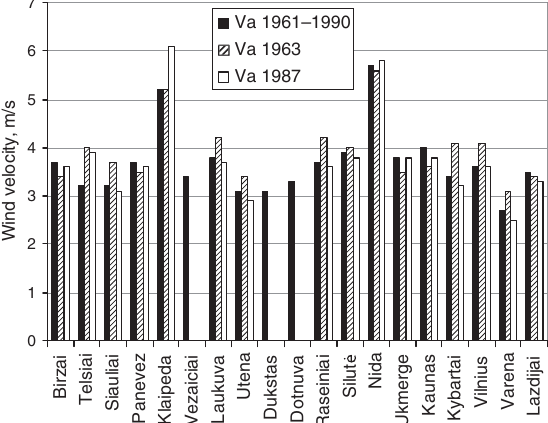
Fig. 2. The average wind velocity in the sites of Lithuanian meteorological stations at 10 m height above ground level for different time measurement